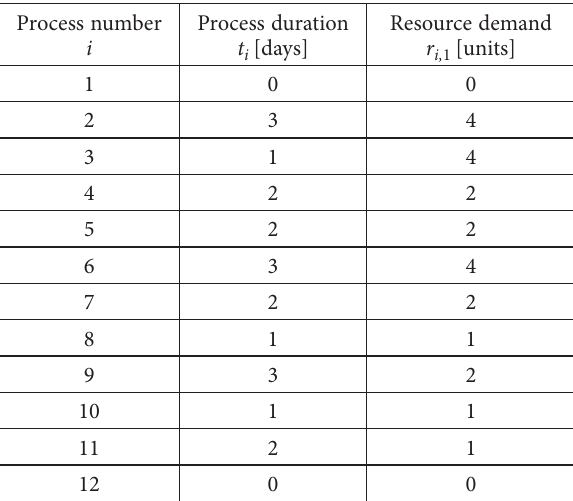
Table 2. Input data